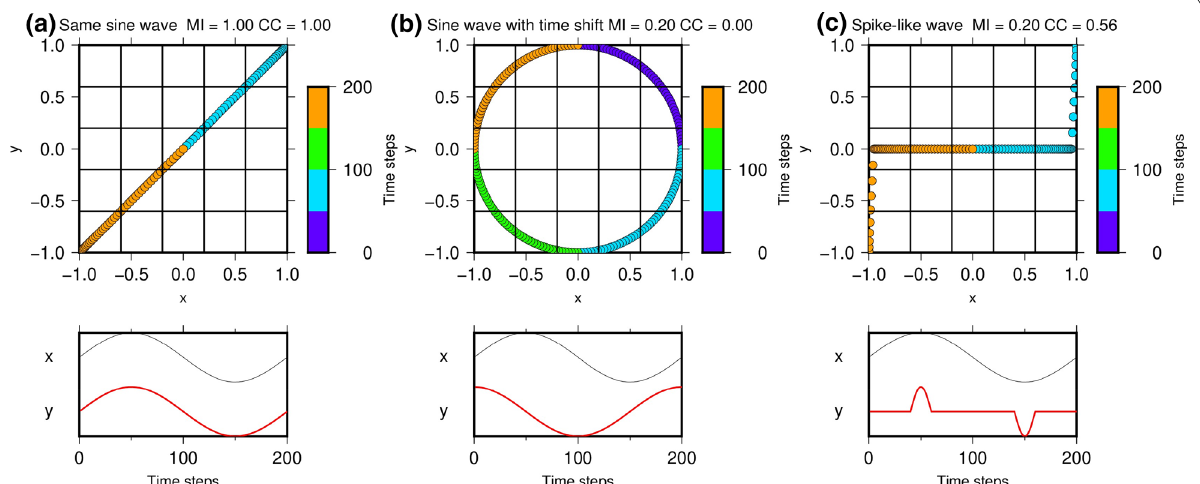
Fig. 1 Scatter plots of relations between two variables (top) and their waveforms at the same time (bottom). MI and CC are given above the plots. Black grid lines correspond to the borders of the bins used to calculate MI. A given time step represents each sample of velocity data in a given time window and its associated sampling rate. a Two variables with the same sinusoidal waves. b Two variables with sinusoidal waves and a time shift. c One variable with a sinusoidal wave and one with a spike-like